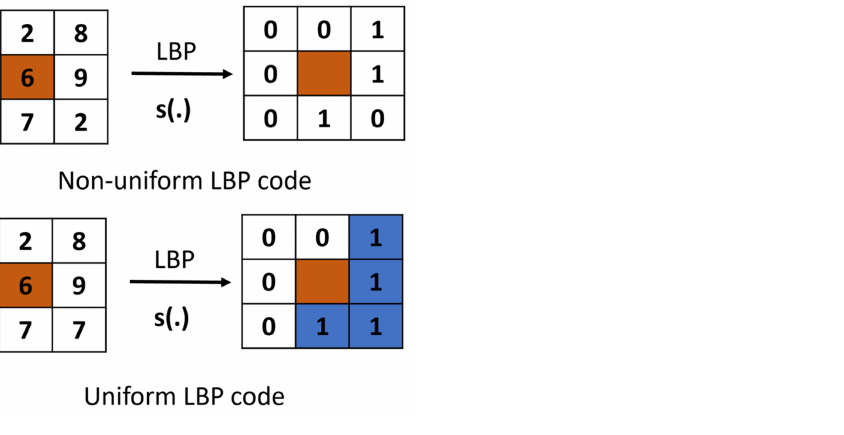
Figure 3. A representation of how the LBP code is calculated based on the function s ( . ) with a uniform and non-uniform